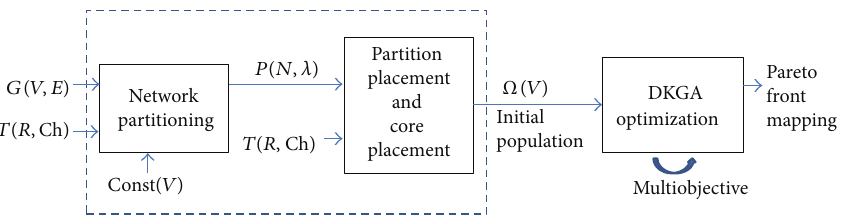
Figure 1: Overview of the proposed technique, NP-DKGA. Dashed-box shows network partitioning phase as initial population for multiobjective